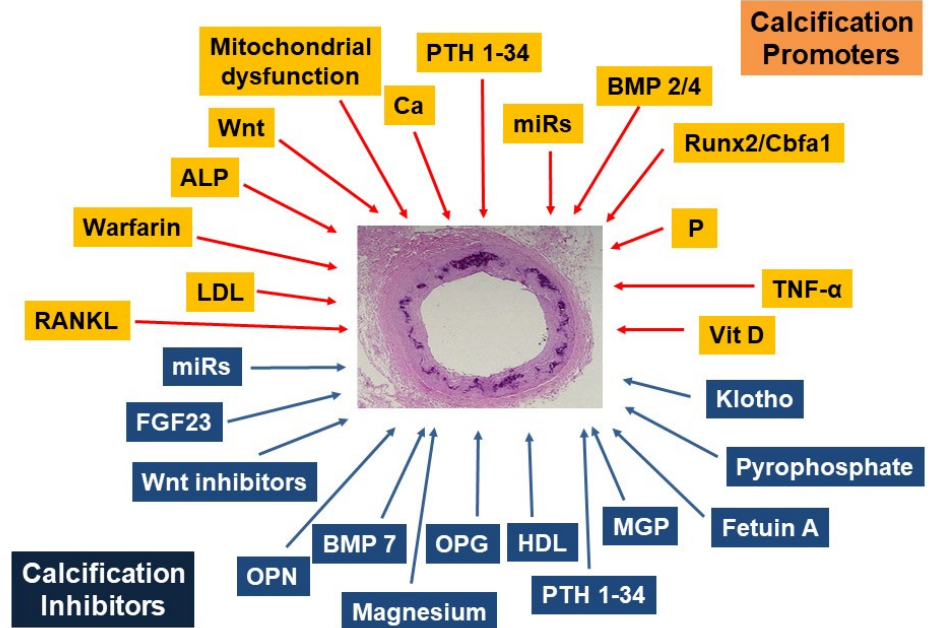
Figure 2. Promoters and inhibitors of vascular calcification. RANKL, receptor activator of nuclear factor-kappa B Ligand; LDL, low-density lipoprotein; ALP, alkaline phosphatase; Ca, calcium; BMP, bone morphogenetic proteins; P, phosphate; TNF- α , tumor necrosis factor-alpha; Vit D3, calcitriol; MGP, matrix GLA protein, HDL, High-density lipoprotein; OPG, osteoprotegerin; OPN, osteopontin; FGF23, fibroblast growth factor 23. (Modified with permission of Oxford University Press from [12]).